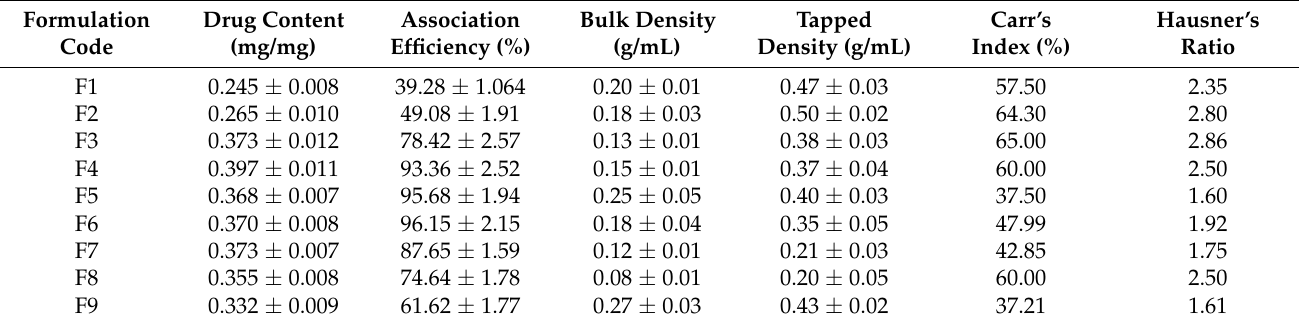
Table 3. Drug content, density and flow characteristics of the spray-dried